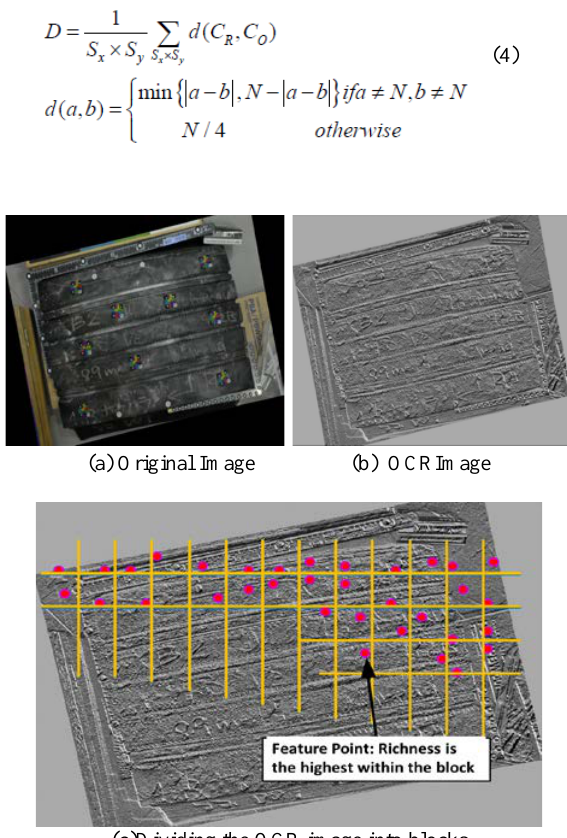
Figure 3. Feature points detection from OCR